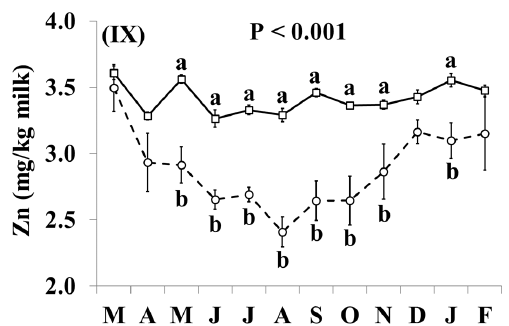
Figure 4. Interaction means ± SE (error bars) for the effects of species (cow, goat) and month (in order of appearance from left to right in Axis X: M, March; A, April; M, May; J, June; J, July; A, August; S, September; O, October; N, November; D, December; J, January; F, February) on mineral